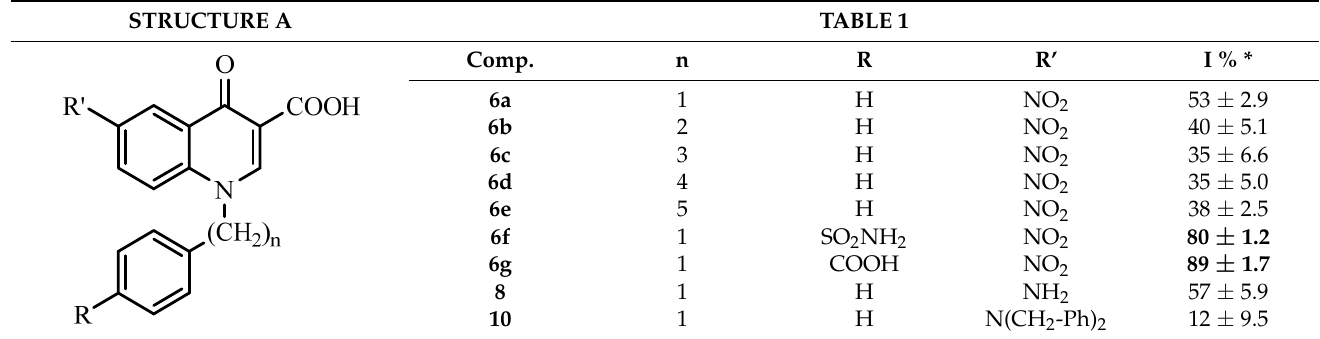
Table 1. Inhibition (%) values of compounds 6a – g , 8 and 10